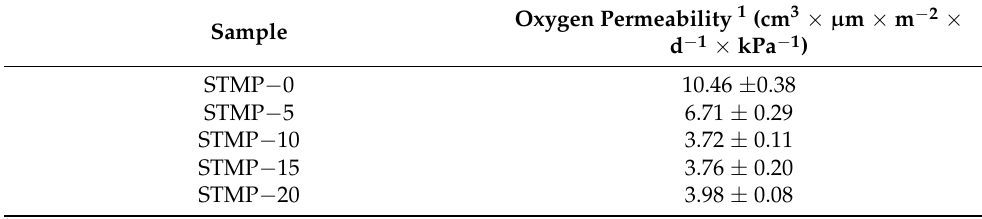
Table 4. Oxygen permeability of STMP crosslinked hemicellulose films